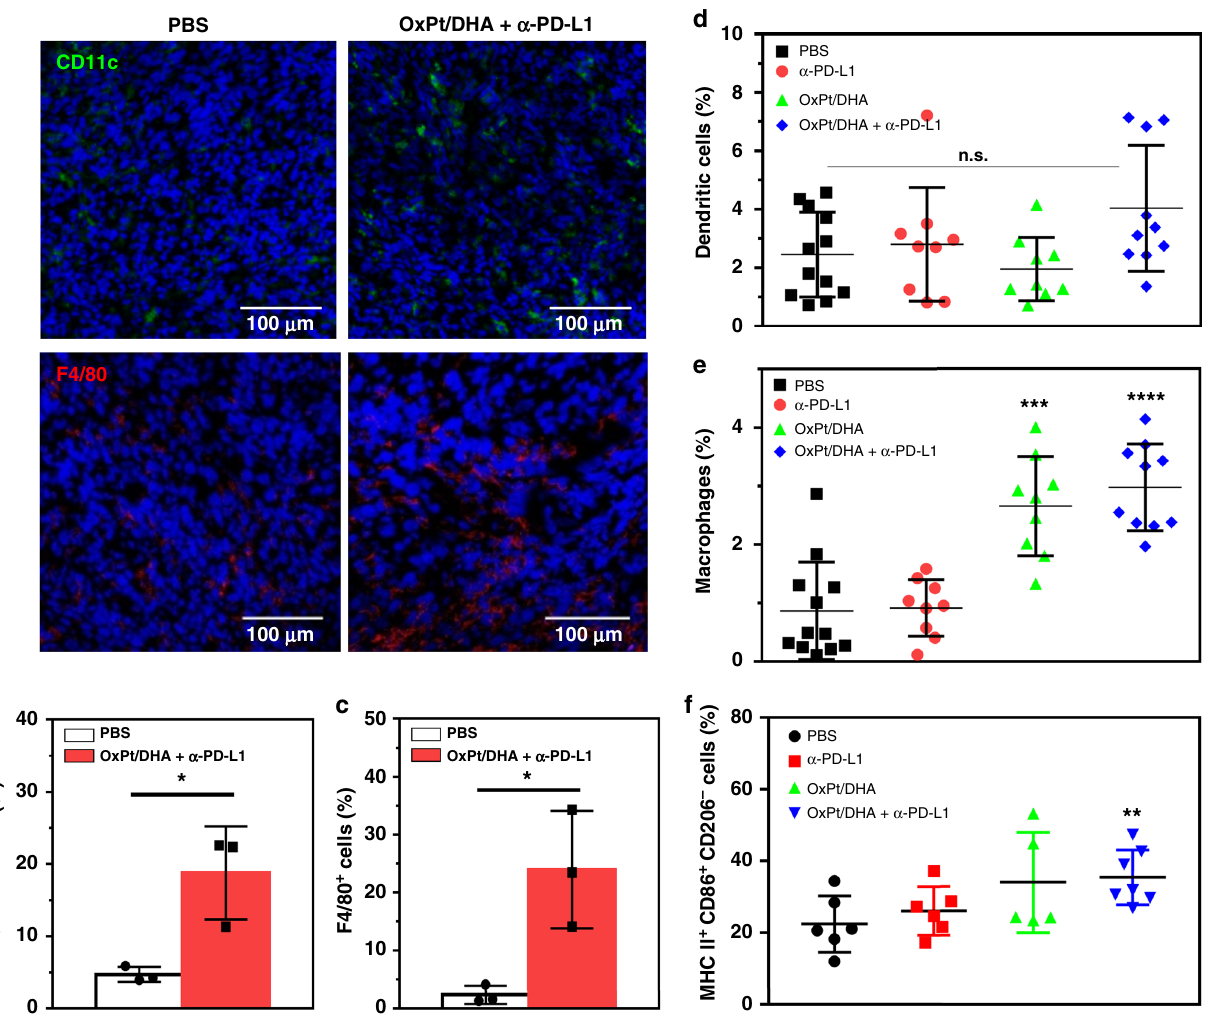
Fig. 7 Tumour in fi ltration of innate immune cells. a Immuno fl uorescence analysis showing the in fi ltration of dendritic cells and macrophages 2 days after treatment. b , c The densities of CD11c + ( b ) and F4/80 + ( c ) cells in the whole tumours 2 days after treatment, from the confocal images of immuno fl uorescence staining ( n = 3). d , e The percentages of dendritic cells ( d ), total macrophages ( e ) and M1 macrophages ( f ) by fl ow cytometry of cell- surface staining 12 days after the fi rst treatment. Data are each pooled from three independent experiments for ( d ) and ( e ). Data were obtained without repetition for ( f ). * p < 0.05, ** p < 0.01, *** p < 0.001, **** p < 0.0001 by Student ’ s two-tailed t